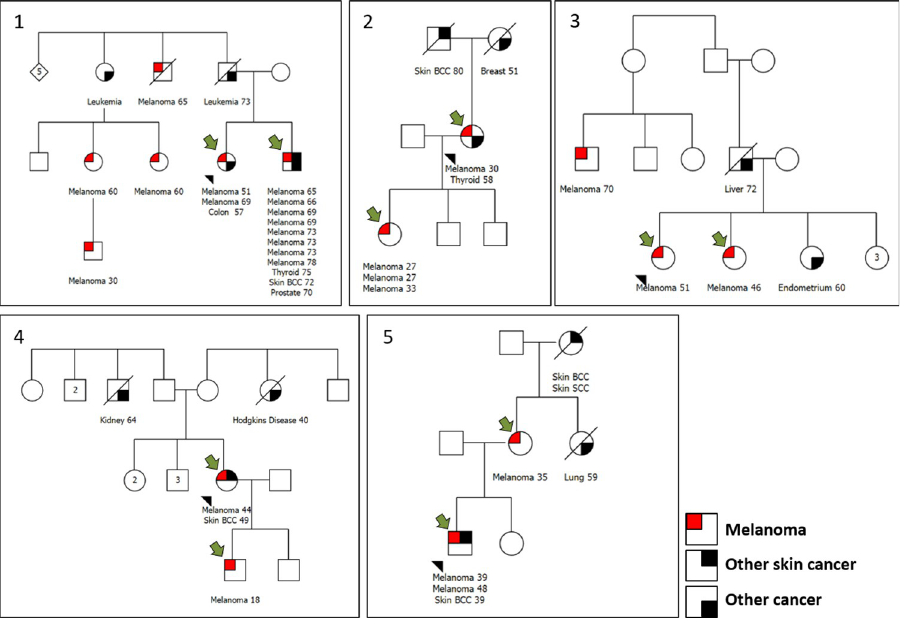
Fig 1. Pedigrees of the five melanoma-prone families. Tumor types are described beneath each individual, followed by the age of onset. Small black arrow indicates the index case of each family. The green arrow indicates the individuals who were subjected to WES